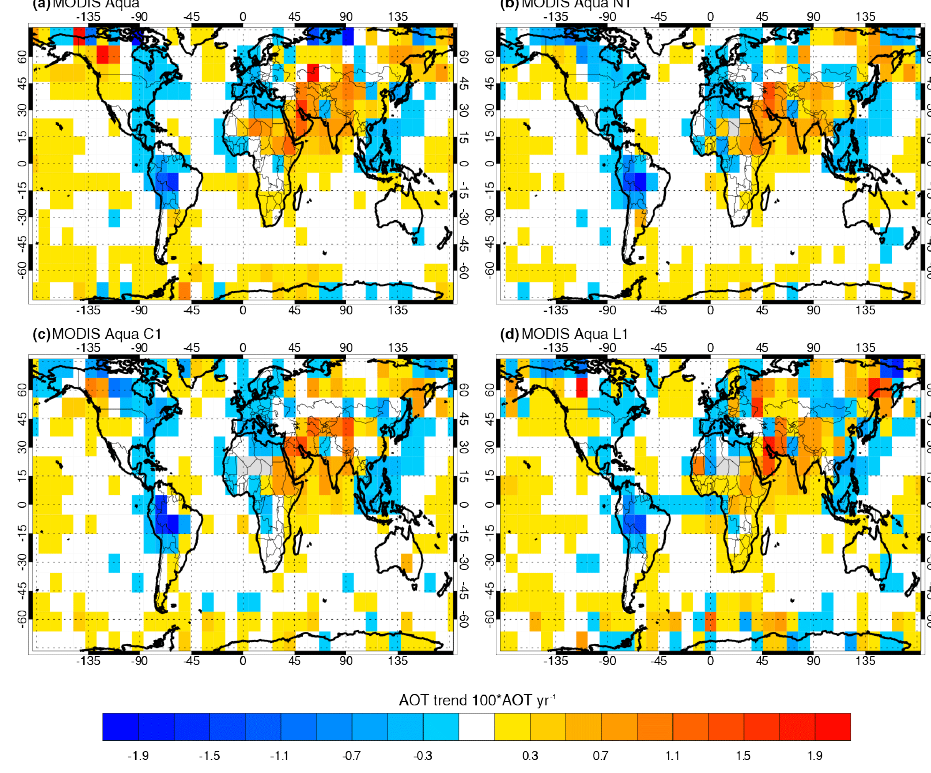
Figure 14. Aerosol trends for the (a) full swath, (b) N1, (c) C1, and (d) L1 samplings at 10 ◦ × 10 ◦ aggregation